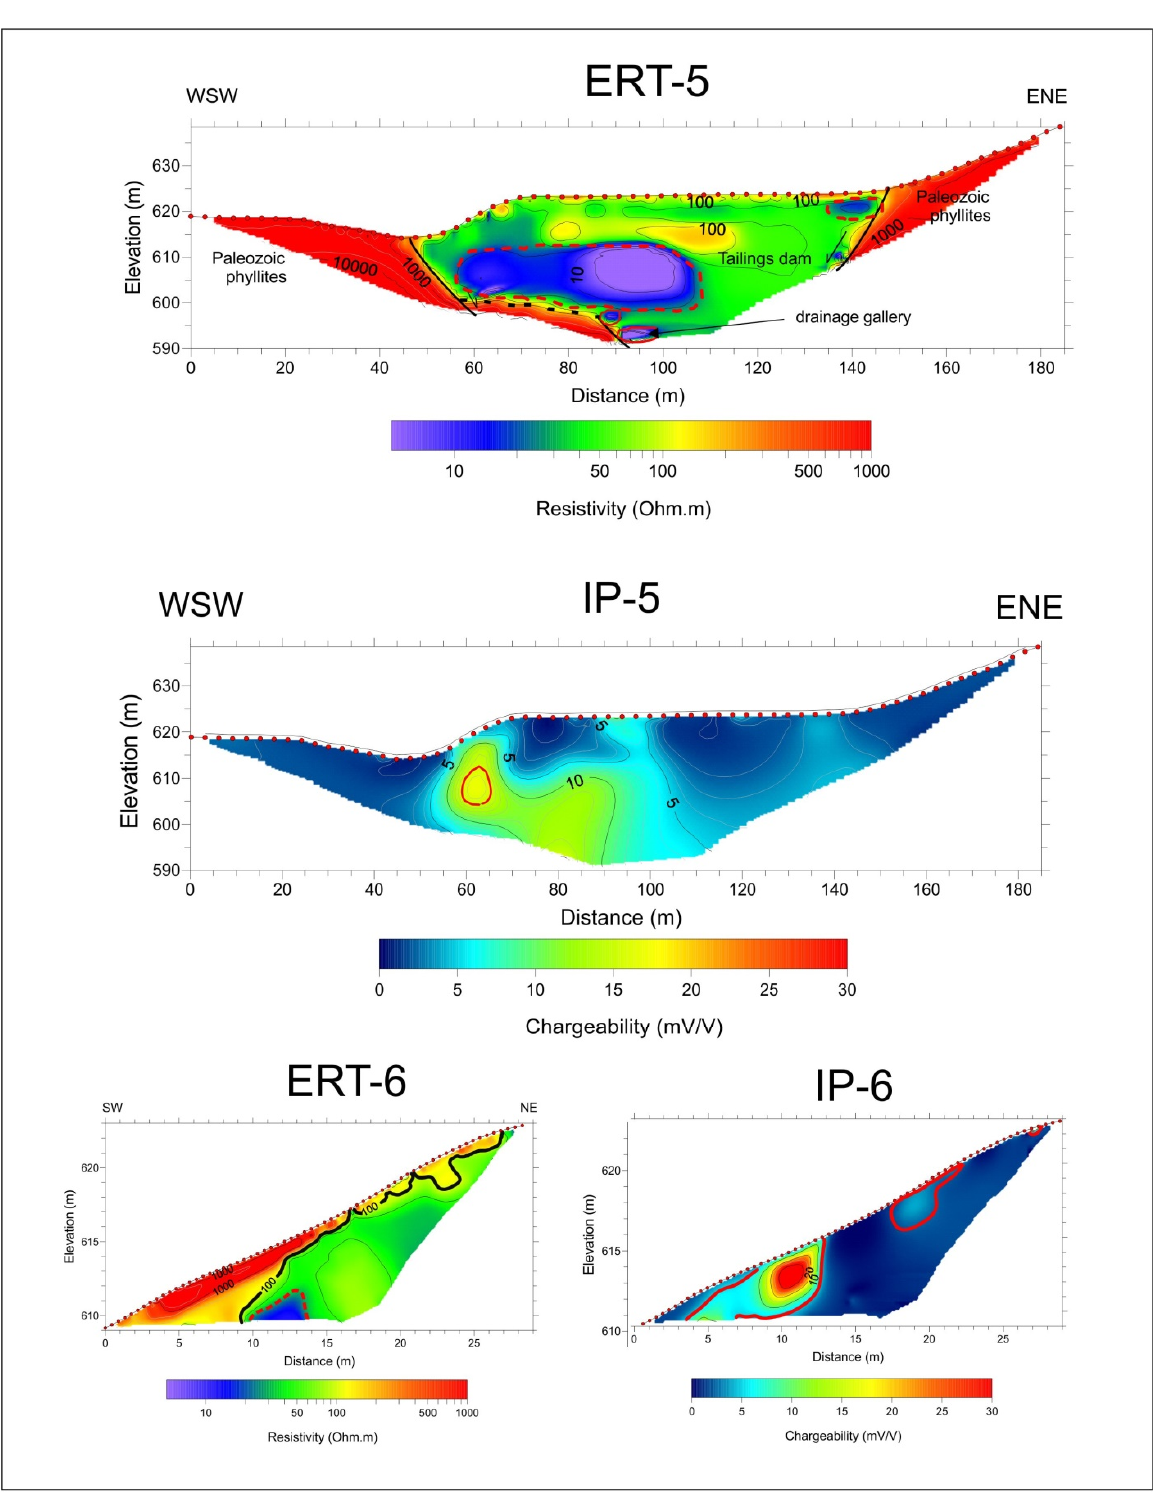
Figure 6. Resistivity models ERT-5 and ERT-6, the underlying Palaeozoic (phyllites) with high resistivity values (red co-lors) on the sides of the profiles, and flotation waste with low resistivities (blue and green colors) are observed, which indicate wet areas (dashed red line). ERT-6 (dam slope) exhibits a different response to the waste, with low values (in blue and green) in areas with specific moisture levels. Yellow colors are associated with crust. In IP model IP-5, low chargeability values are observed, with the medium chargeability zone associated with wet sludge. IP-6 exhibits a strong chargea-bility anomaly probably associated with levels of disseminated sulphides and metal(loid)s-enriched crust.